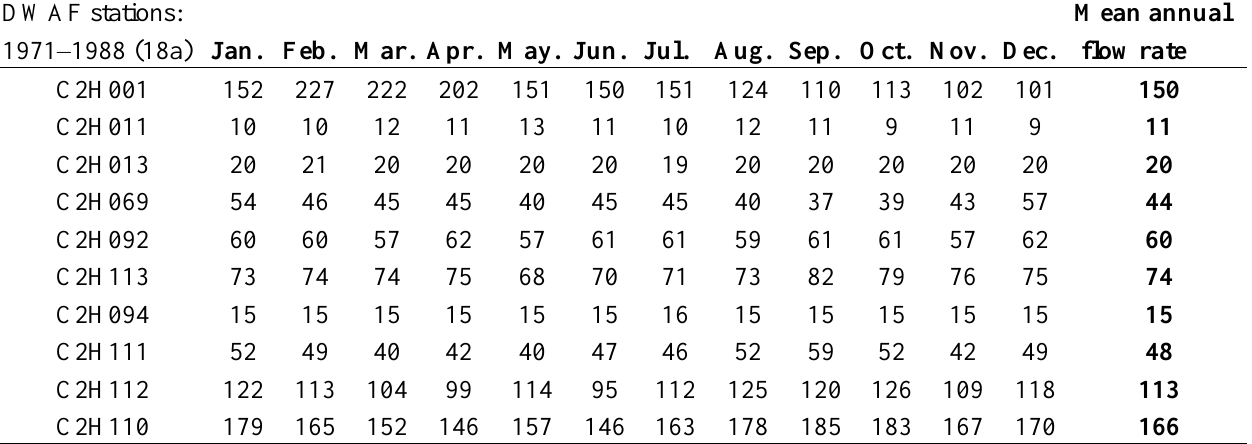
Table 1. Average flow rates [ML/d] of selected gauging stations in and around the Gerhard Minnebron wetland covering the period 1971–1988 (data: